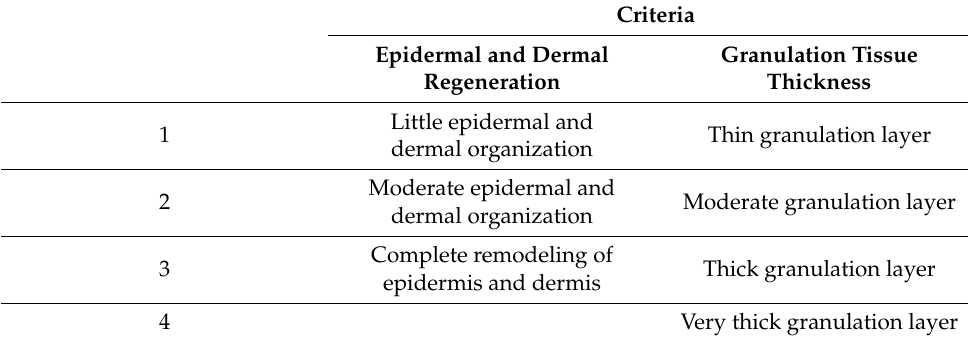
Table 3. Criteria for calculating histologic